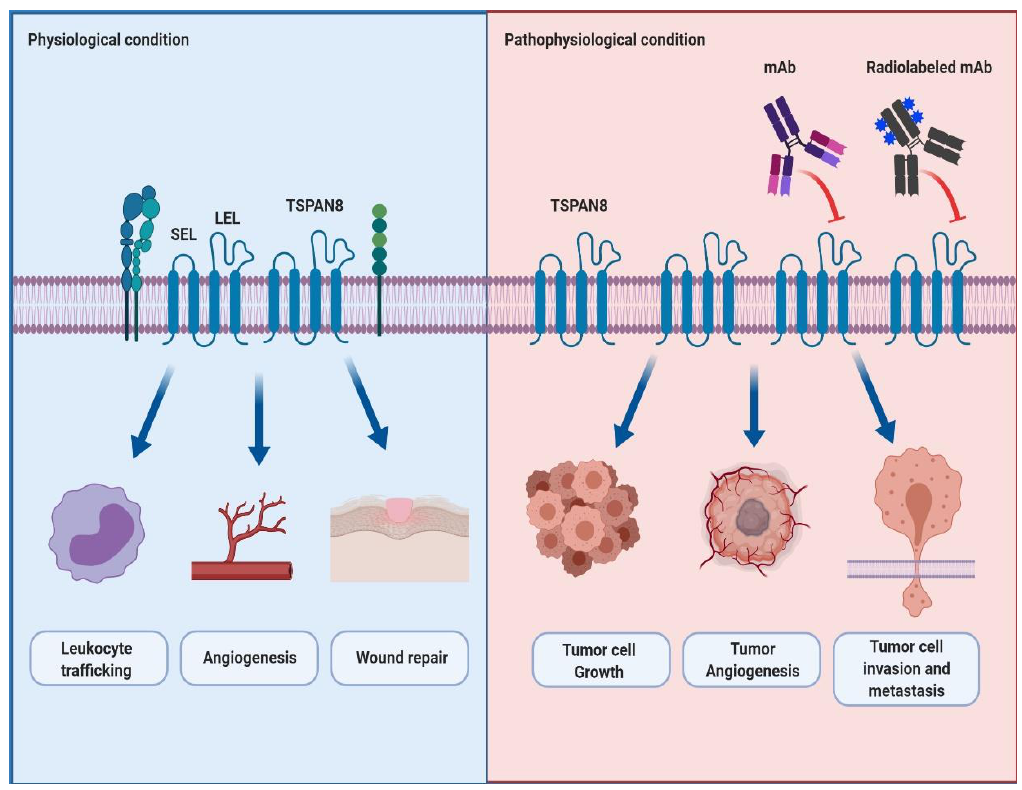
Figure 1. The schematic representation of the physiological and pathophysiological roles of TSPAN8 and the e ff ect of a newly developed antibody targeting TSPAN8 in TSPAN8-mediated cancer progression and metastasis. Under physiological conditions, TSPAN8 interacts with itself and other binding proteins to e ffi ciently convey outside signals to the inside of the cell. It plays a key role in the regulation of many cellular functions such as leukocyte tra ffi cking, angiogenesis and wound repair. Under pathophysiological conditions such as cancers, it has been well-known that TSPAN8-overexpression is closely associated with the cell growth, angiogenesis, and invasion and metastasis of tumor cells. Furthermore, it is also believed that the monoclonal antibody or radiolabeled monoclonal antibody to TSPAN8 may be e ff ective in suppressing TSPAN8-mediated tumor progression and metastasis. Abbreviation: mAb, monoclonal